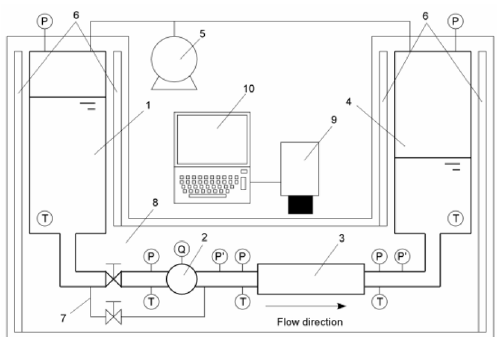
Fig. 1 The schematic illustration of the experimental system: 1) supply tank, 2) turbine flow meter, 3) visualization section, 4) buffer tank, 5) vacuum pump, 6) copper radiation shield, 7) bypass line, 8) vacuum insulation chamber, 9) high speed video camera, 10) measuring